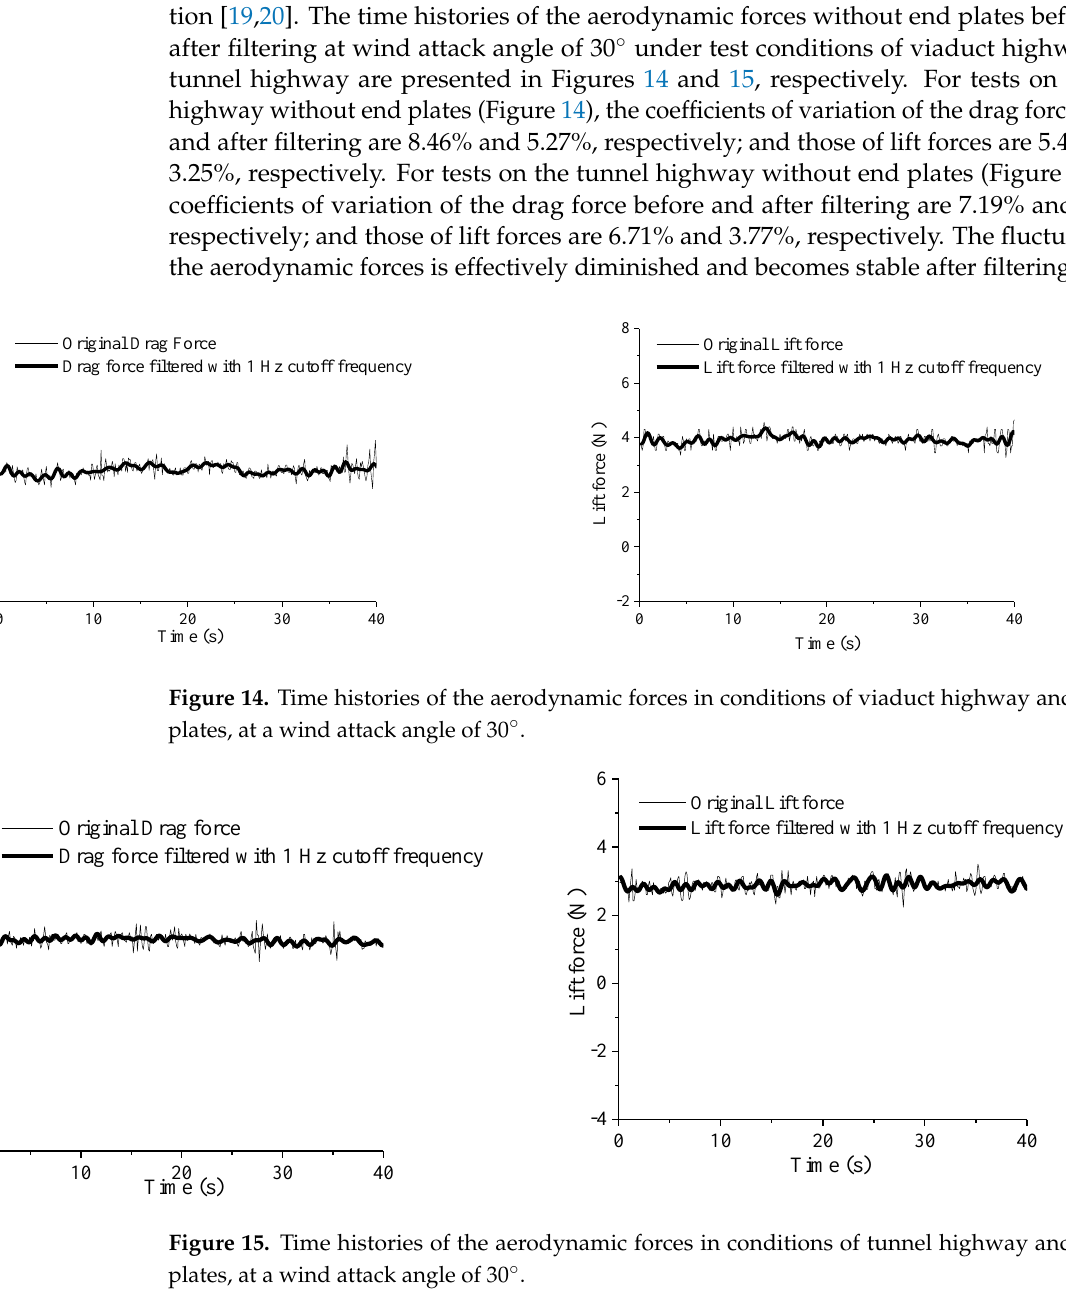
Figure 13. Spectrum diagrams of the aerodynamic force (at wind attack angle of 30°) and vibration accelerations in the corresponding direction under test condition of no end plates and tunnel highway.